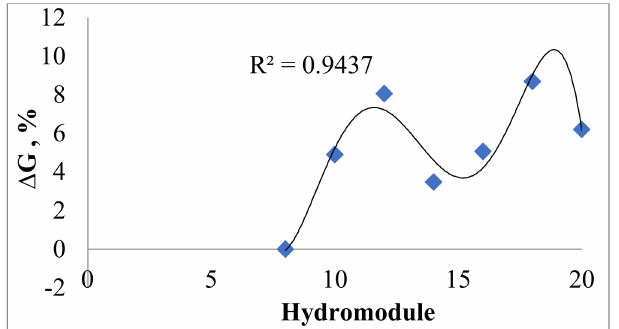
Figure 1. The dependence of the difference of the degree of extraction ( ∆ G) according to the hydro- module.